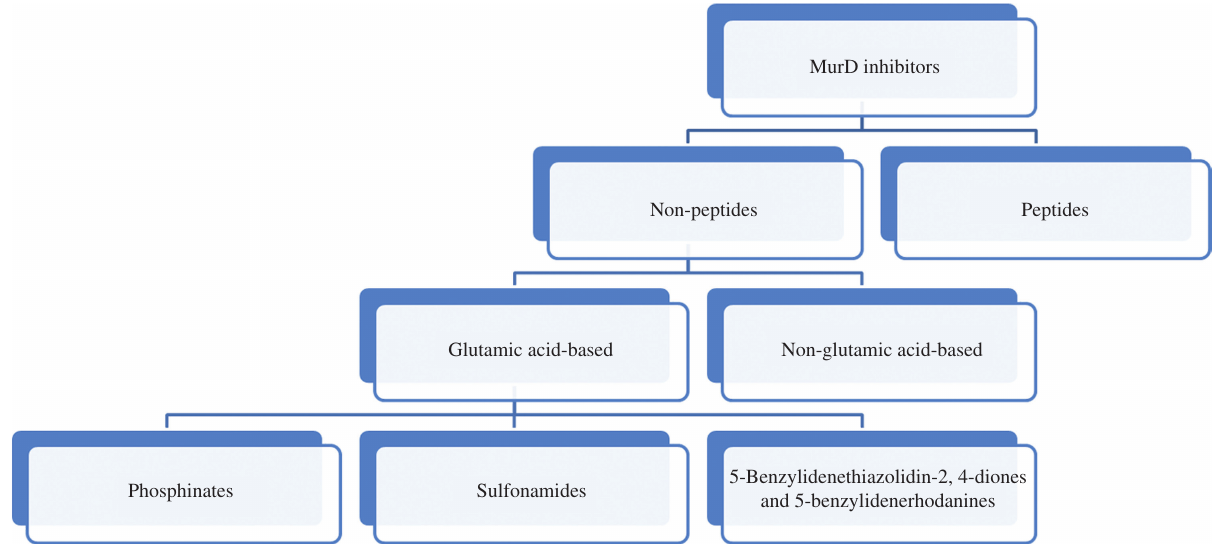
Figure 2 Different classes of MurD